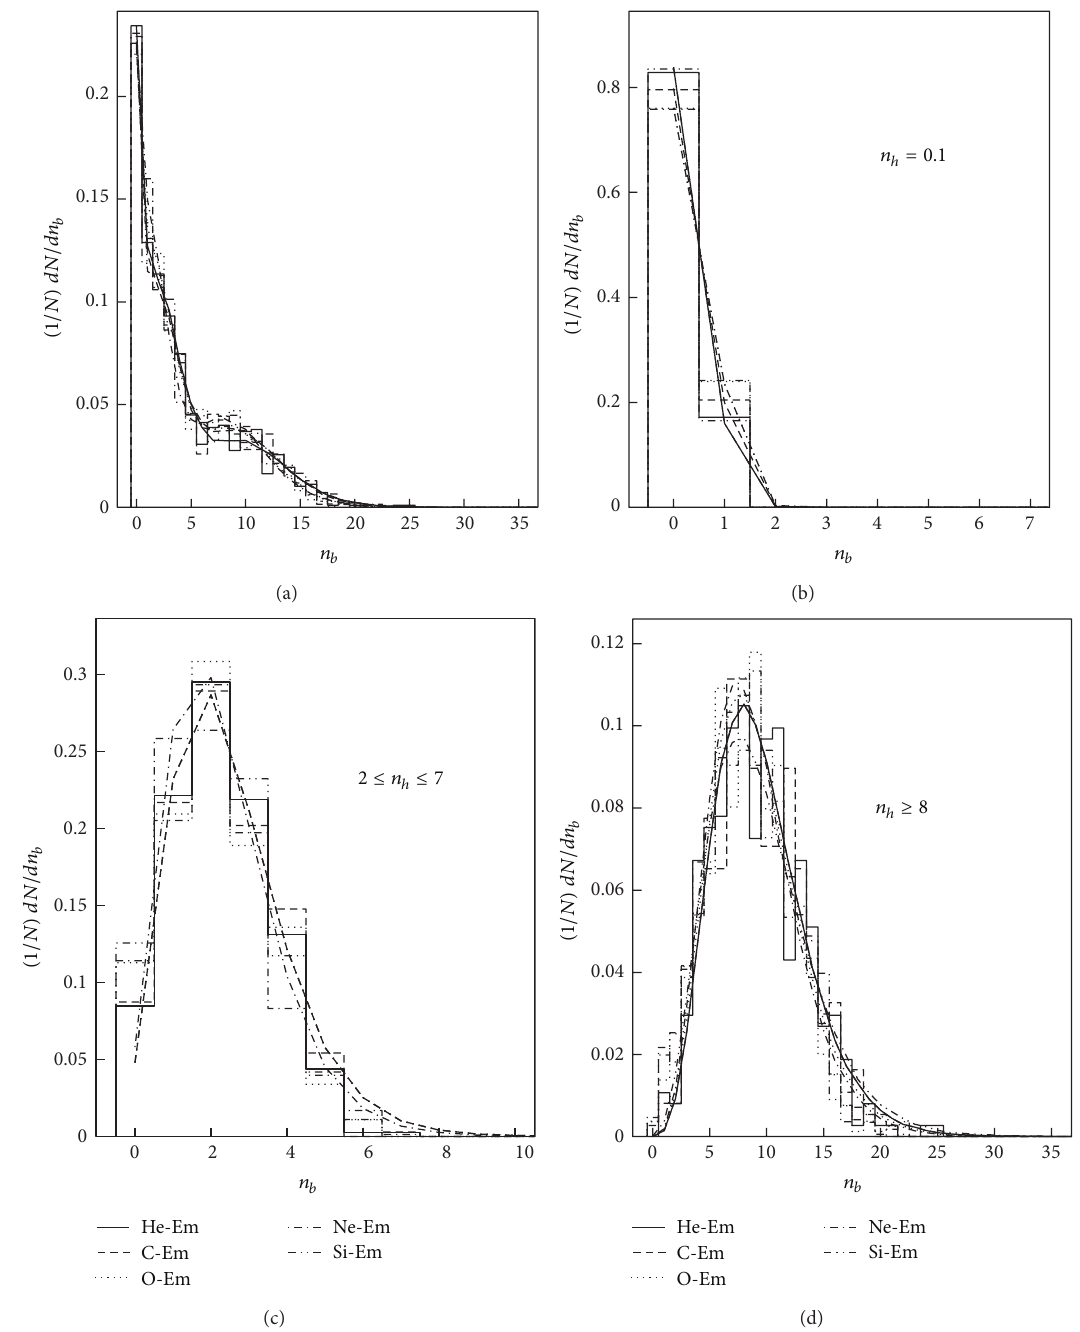
Figure 3: The normalized multiplicity distributions for black particles produced in the interactions of projectiles with (a) Em, (b) H, (c) CNO, and (d) AgBr, respectively. The histograms represent the experimental data, while the curves are the corresponding ones calculated according to the multisource thermal